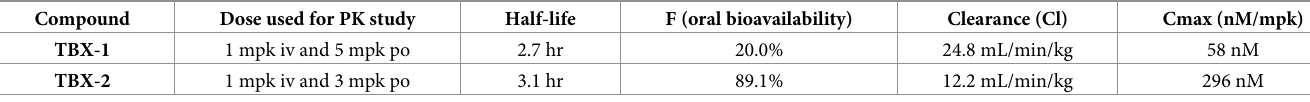
Table 1. In vivo pharmacokinetic evaluation of compounds TBX-1 and TBX-2.